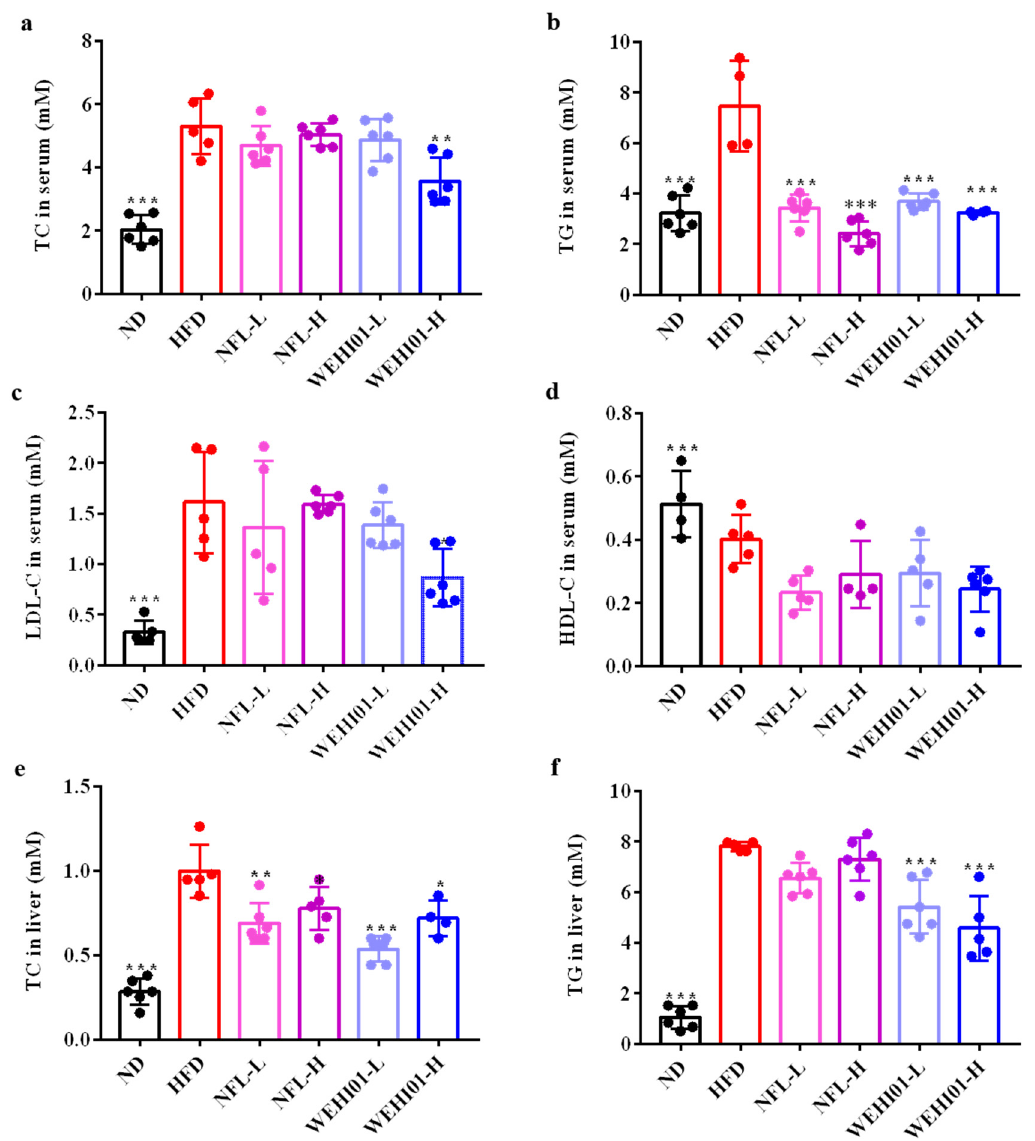
Figure 6. Effect of FLLS-WEHI01 on lipid levels of serum and liver in obese rats. ( a ) TC level in serum. ( b ) TG level in serum. ( c ) LDL-C level in serum. ( d ) HDL-C level in serum. ( e ) TC level in liver. ( f ) TG level in liver. Values were expressed as mean ± SD ( n = 6). * p < 0.05, ** p < 0.01, and *** p < 0.001 vs. HFD group.